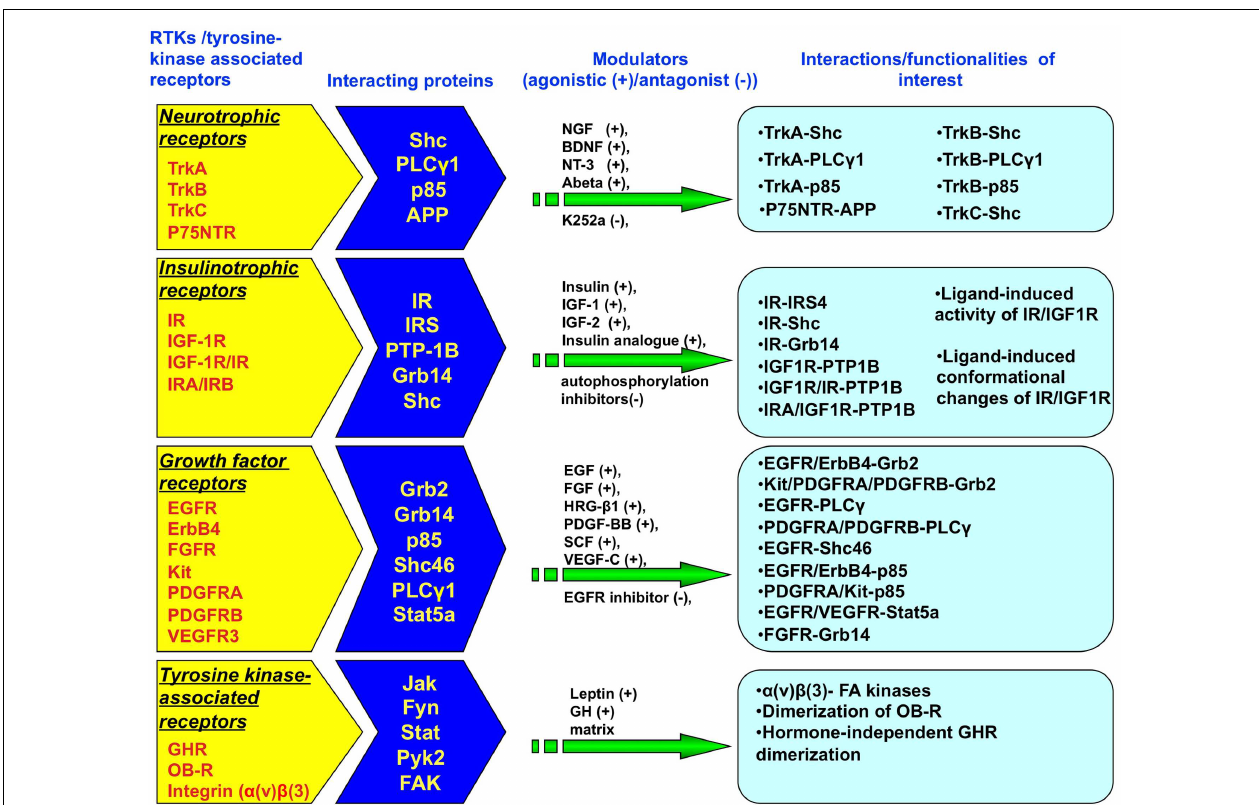
conformational changes in receptor structure.The RTK receptors include neurotrophic receptors (TrkA,TrkB,TrkC, p75NTR), insulinotropic receptors (IR, IGF-1R, IR-IGF-1R hybrid receptors), and growth factor receptors (FGFR, EGFR, ErbB4, kit, PDGFRA/B,VEGFR3).Tyrosine kinase-associated receptors include GHR, OB-R, and integrin